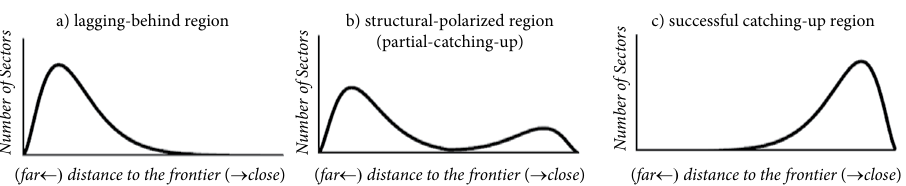
( far ←) distance to the frontier ( → close ) Fig. 1. Theoretical patterns of the distribution of sectors according to their technological gap Source : (Lavopa, Szirmai 2011) reproduced with permission from authors.